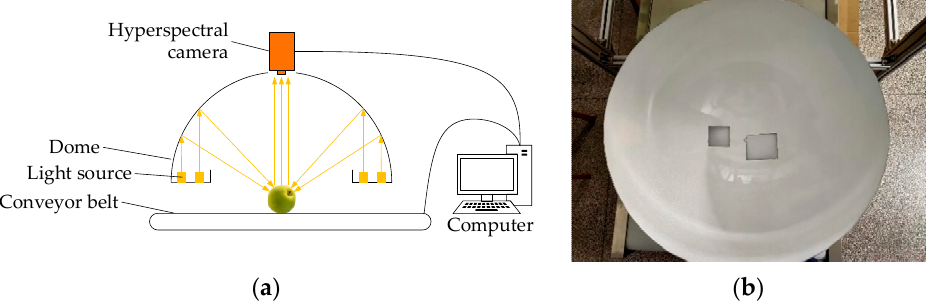
Figure 1. Hyperspectral imaging system and dome. ( a ) Hyperspectral imaging system. ( b ) Dome. Table 1. Parameters of Gaiafield-V10E-AZ4 hyperspectral camera.